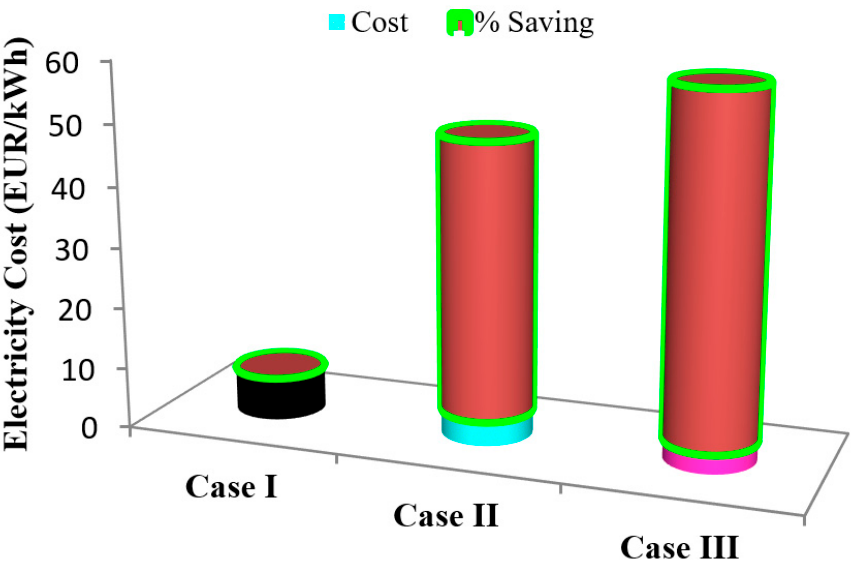
Figure 15. Comparison of average daily energy consumption and cost management for 20 users within cases I, II, and III.